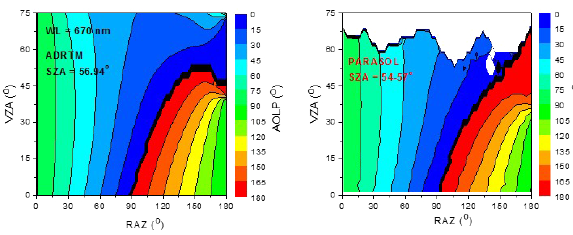
Figure 13. Comparison of the modeled AOLP of desert-reflected solar light with those from the PARASOL data at the wavelength of 670nm. The SZA is 56.94 ◦ in the modeling. The SZA is in the bin of 54–57 ◦ for the PARASOL data.